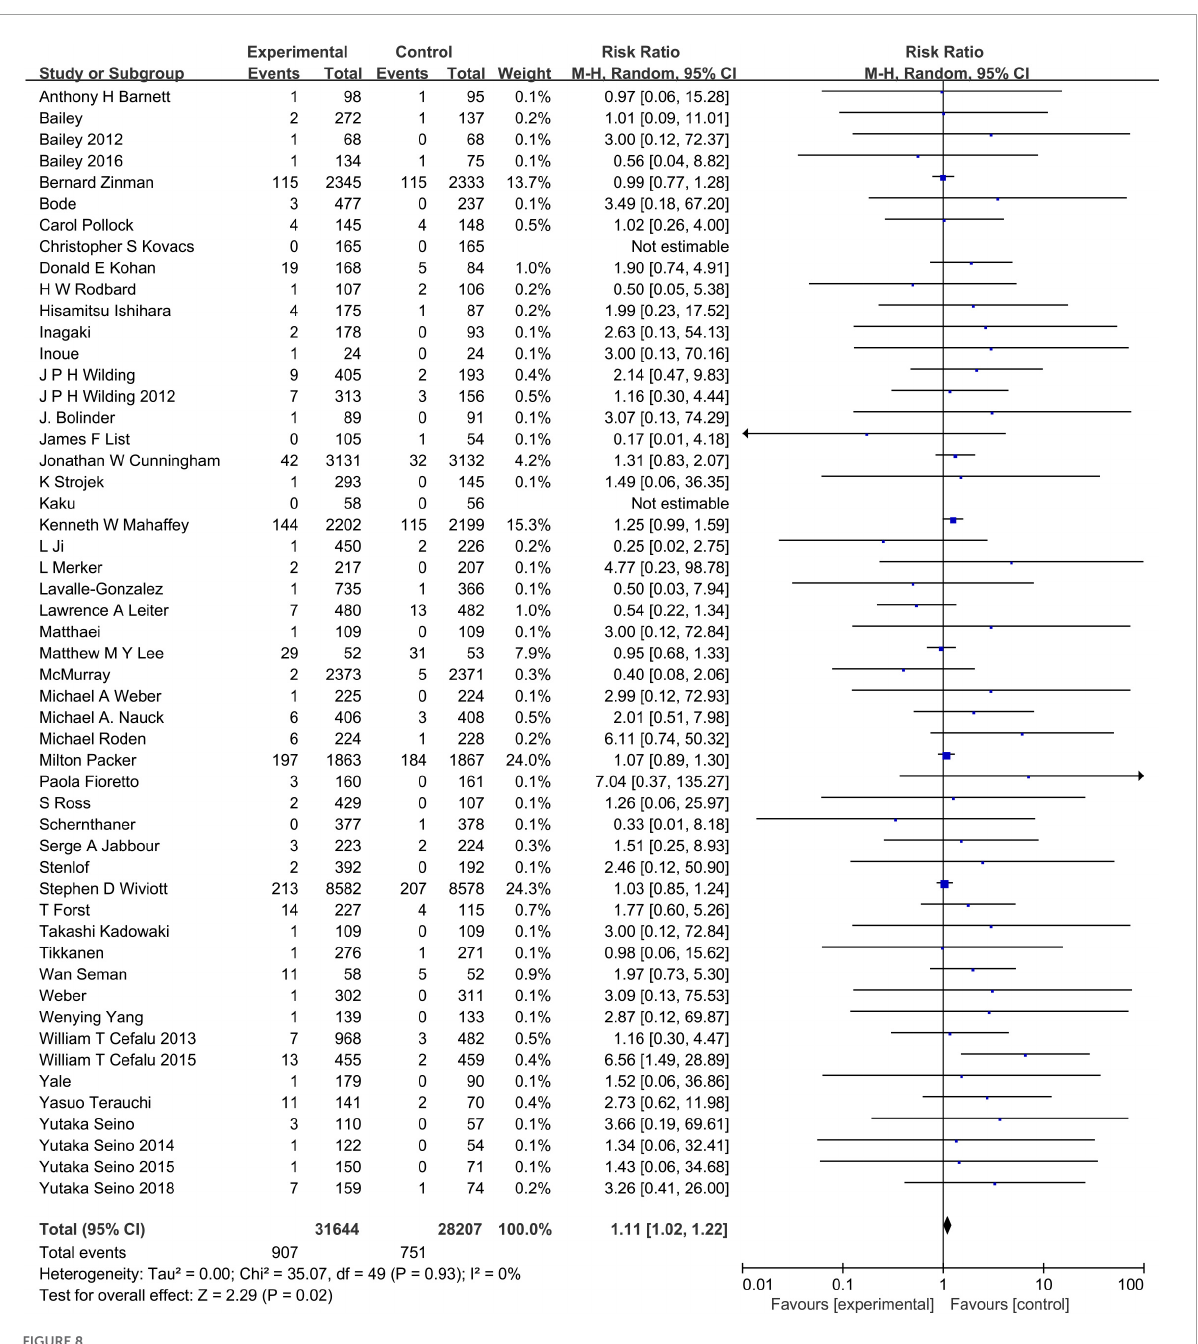
risk of hypovolemia associated with SGLT2 inhibitors under the context of some heart failure guidelines recommending prescribe SGLT2 inhibitors for heart failure patients with or without T2DM. The interrelation between SGLT2 inhibitors and hypovolemia and the underlying mediating mechanisms of cardio-protection deserves to be further investigated. It